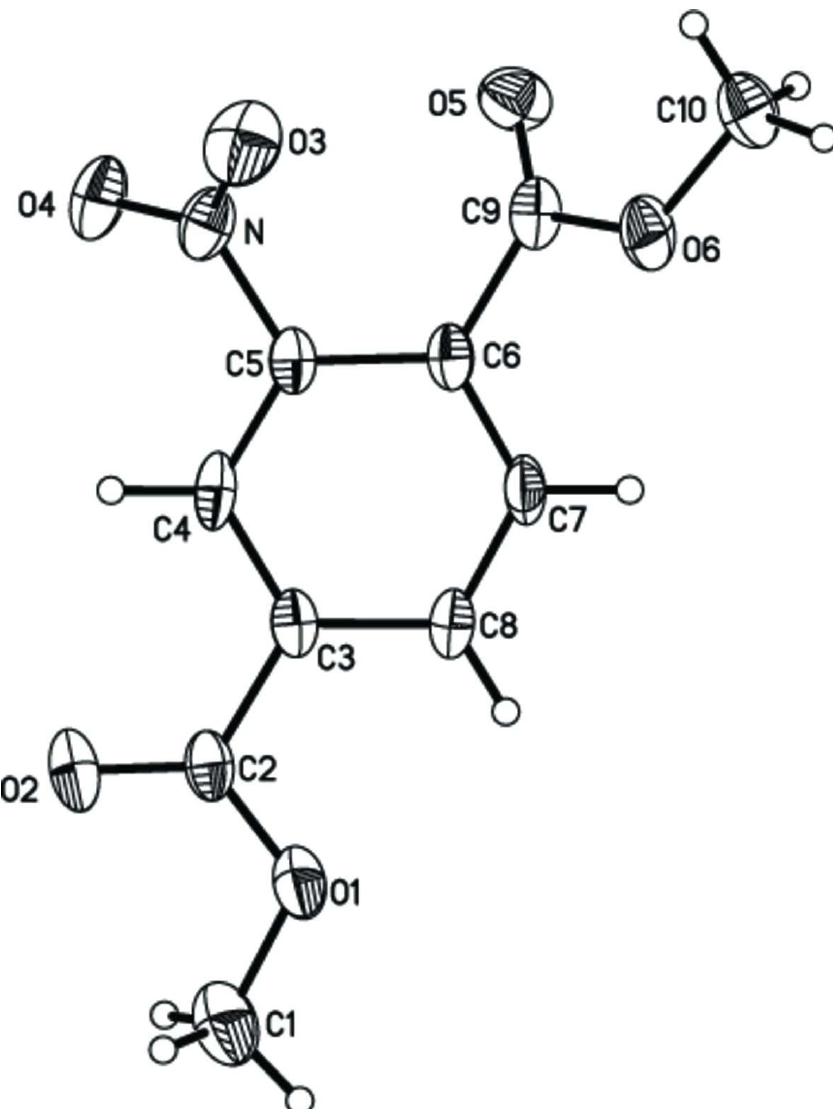
A view of the molecule of (I) with the atomic numbering scheme. Displacement ellipsoids were drawn at the 30% probability